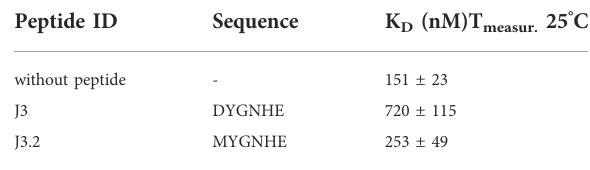
TABLE 3 Dissociation constants of the RBD- h ACE2 complex determinedon the basisof the MST experimentswith and without tested